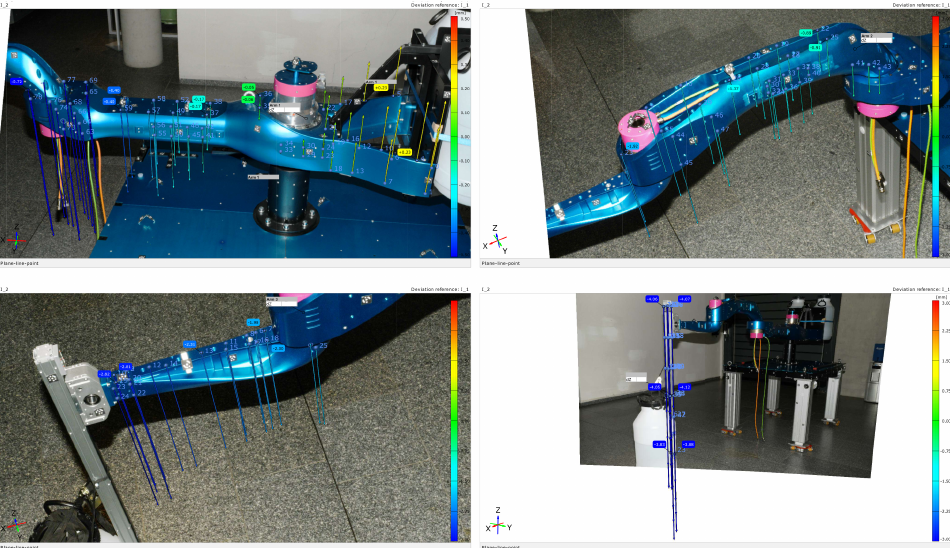
Figure 11. XY displacements of point components of Arms 1–3 and the actuator in the z -axis (State I_2 vs. I_1).